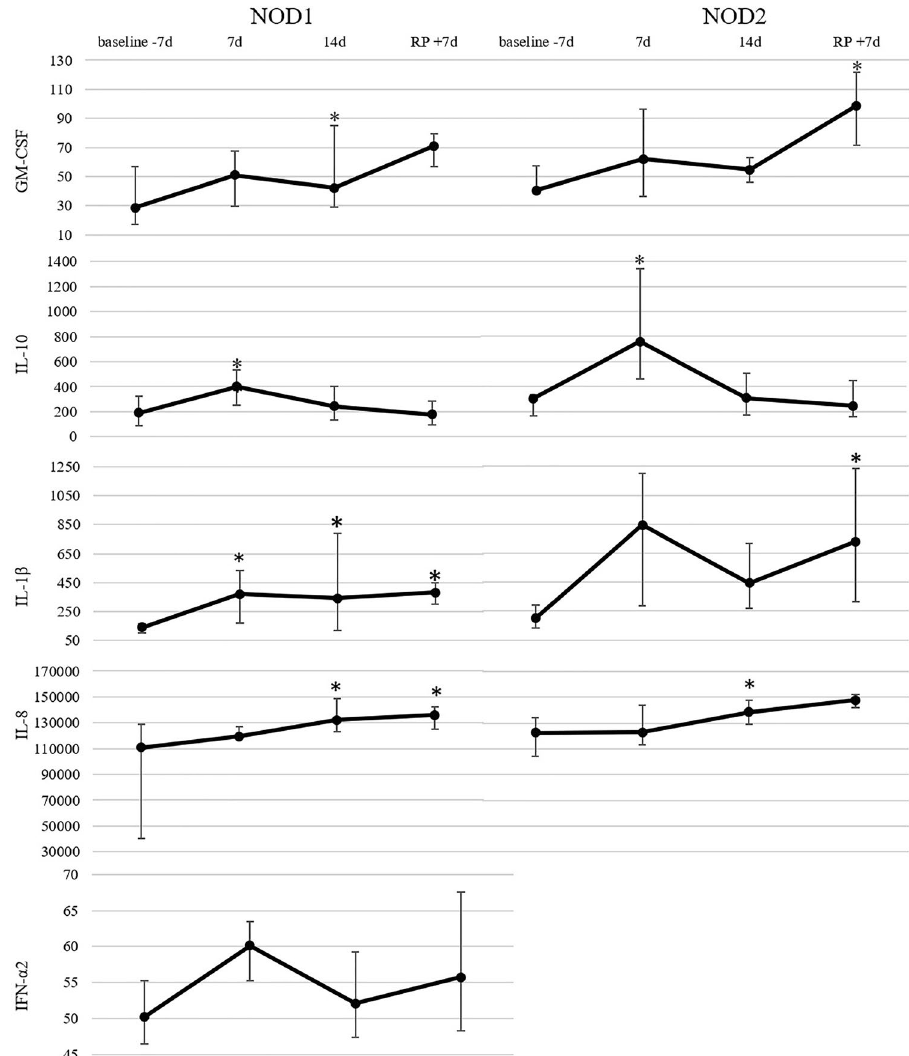
Figure 5. Induced cytokine synthesis in cultured monocytes stimulated with the corresponding NOD1 or NOD2 ligands. All values are presented in pg/ml. Markers represent medians, whiskers represent quartiles q75 and q25; asterisk (*) indicates p-value ≤ 0,05 in Wilcoxon